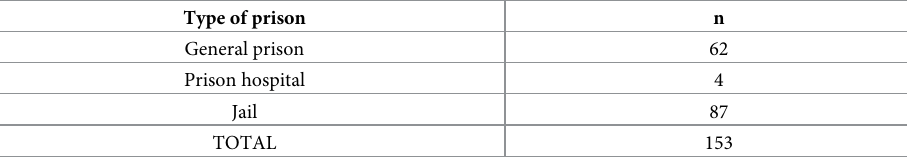
Table 1. Type of correctional facilities covered in this study.